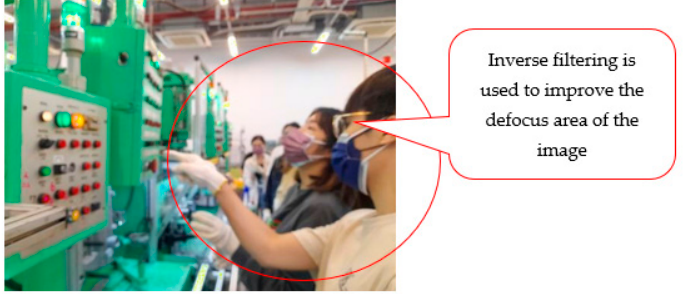
Figure 11. The output of image inverse fi ltering from the defocus image.